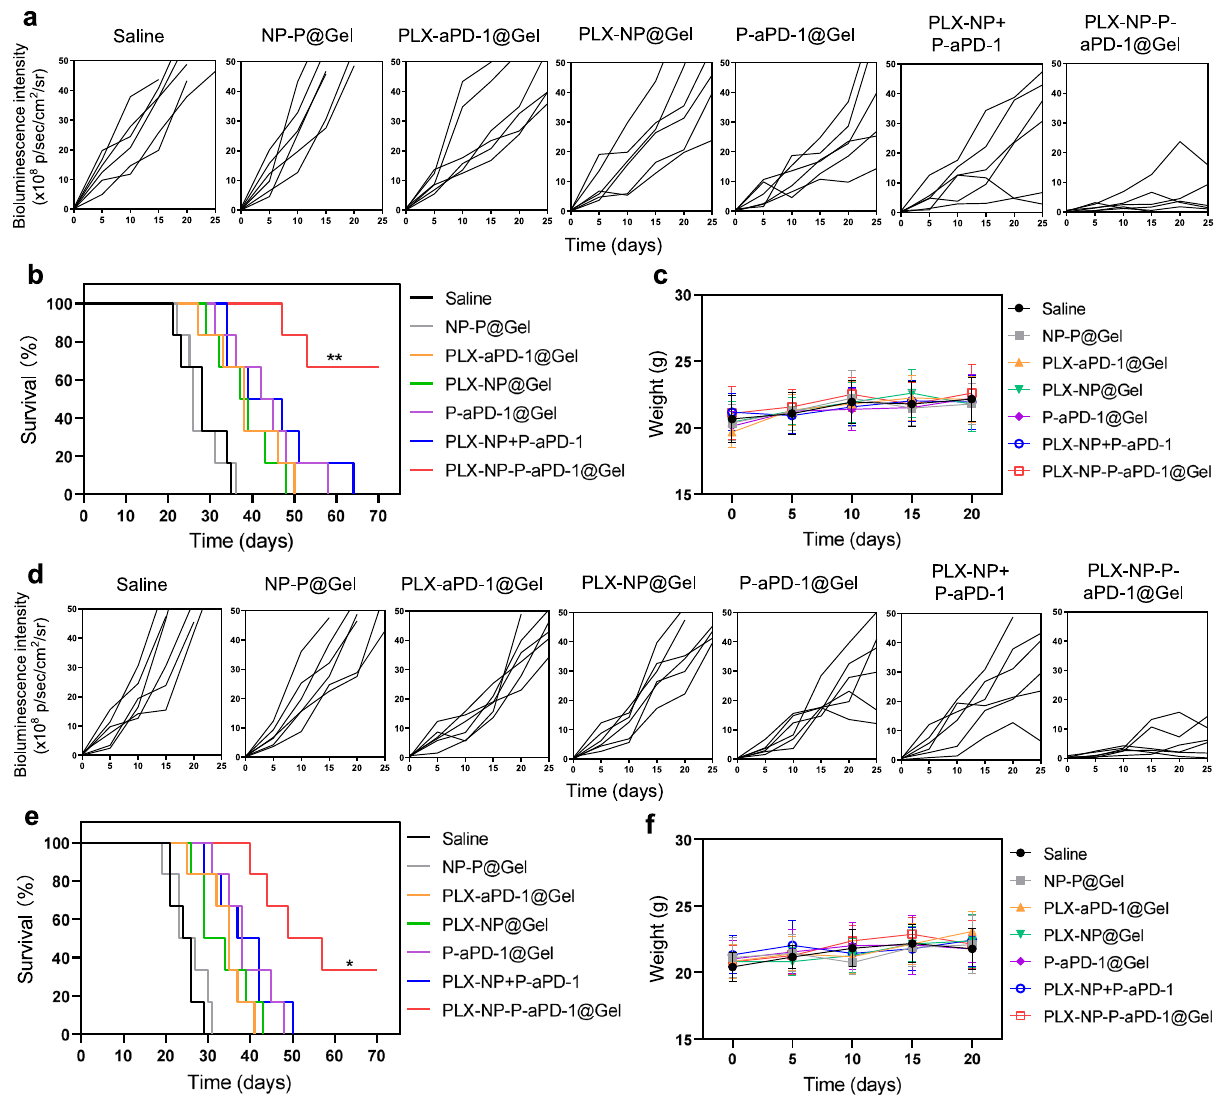
Fig. 3 Evaluation of in vivo treatment ef fi cacy of PLX-NP-P-aPD-1@Gel in CT26 and B16F10 tumor recurrence models. a Region-of-interest analysis of bioluminescence intensity of the tumors among different treatment groups in CT26 tumor recurrence model ( n = 6 mice). Saline; NP-P@Gel, blank nanoparticle and unmodi fi ed platelets co-loaded hydrogel; PLX-aPD-1@Gel, free PLX and aPD-1 co-loaded hydrogel; PLX-NP@Gel, PLX-NP loaded hydrogel; doses of PLX and aPD-1 were 5 mg/kg and 0.1 mg/kg, respectively. b Survival curves of the mice treated with different treatment groups in CT26 tumor weight change of mice among different treatment groups in CT26 tumor recurrence model. Data are presented as mean ± s. d. ( n = 6 mice). d Region-of- curves of the mice treated with different treatment groups in B16F10 tumor recurrence model ( n = 6 mice). Data were analyzed with Log-rank